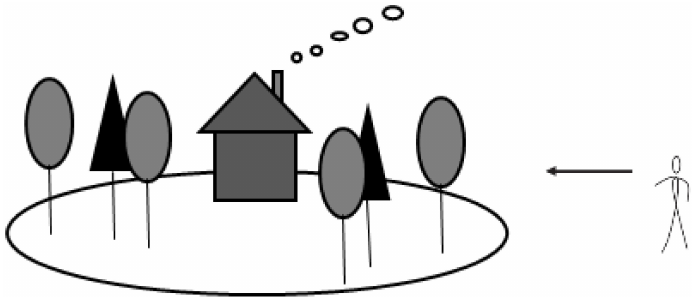
Figure 6. Conceptual model of forest-landscape image for young adults, Central